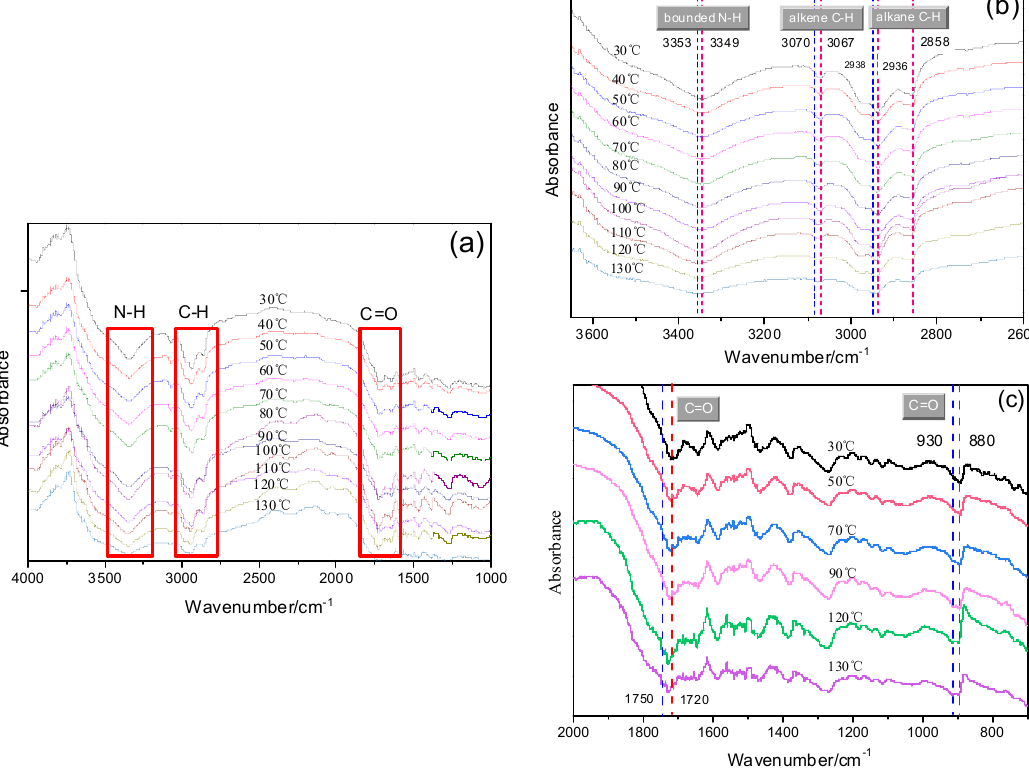
Figure 10 . In situ variable-temperature infrared spectra of PI-UPy: ( a ) whole temperature ranges of initial elastomer sample; ( b ) blue shift of –NH 2 and C–H; ( c ) blue shift of C=O.